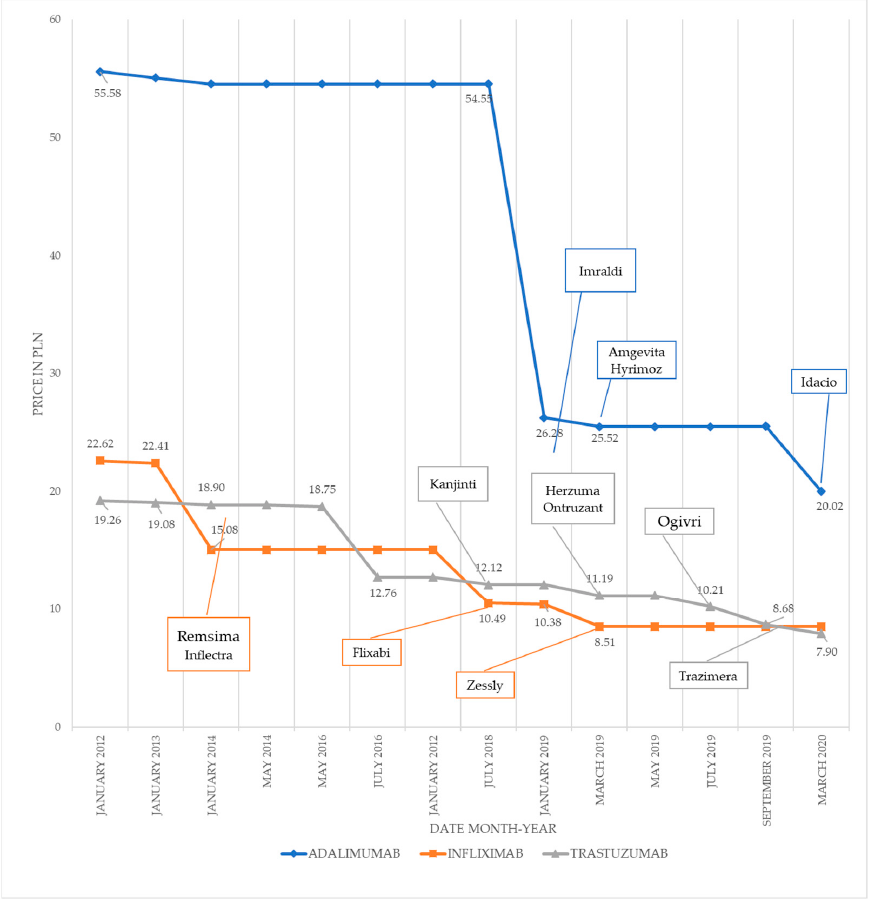
Figure 1. History of price changes between July 2012 and March 2020 (in PLN). Source: own elaboration based on Ministry of Health data [9].